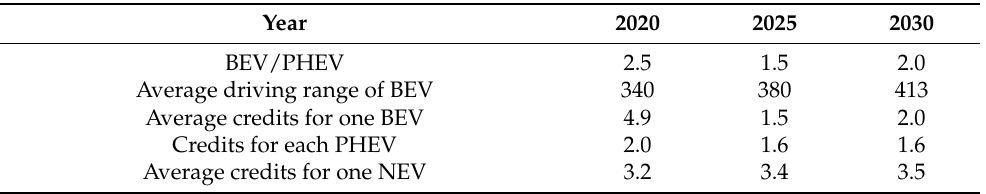
Table 2. The hypothesis about NEV market and credits. BEV: battery electric vehicle; PHEV: plug-in hybrid vehicle; NEV: New Energy Vehicle.